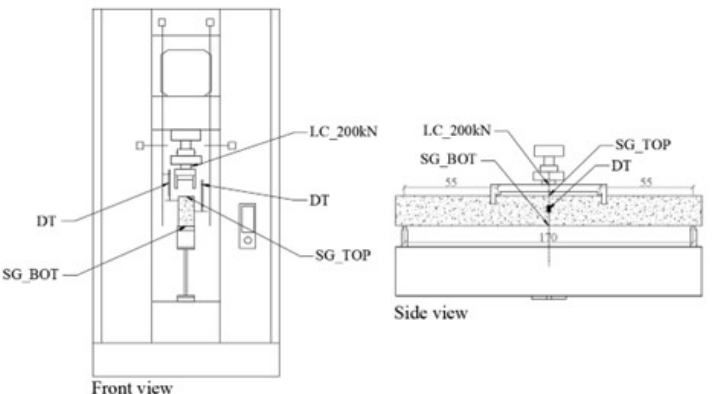
Figure 10. Bending test assembly schematics. Dimensions in centimeters.